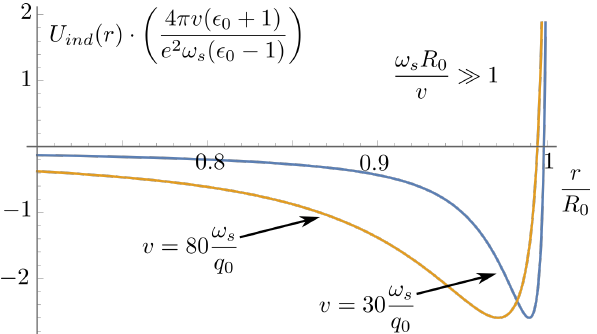
Figure 10. Dimensionless induced potential versus the distance from the cavity axis at the condition ω s R 0 / v (cid:29) 1. Two curves correspond different values of longitudinal velocity. As can be seen, at the particle velocity increase the potential shape does not change, and the curve minimum tends to the cavity